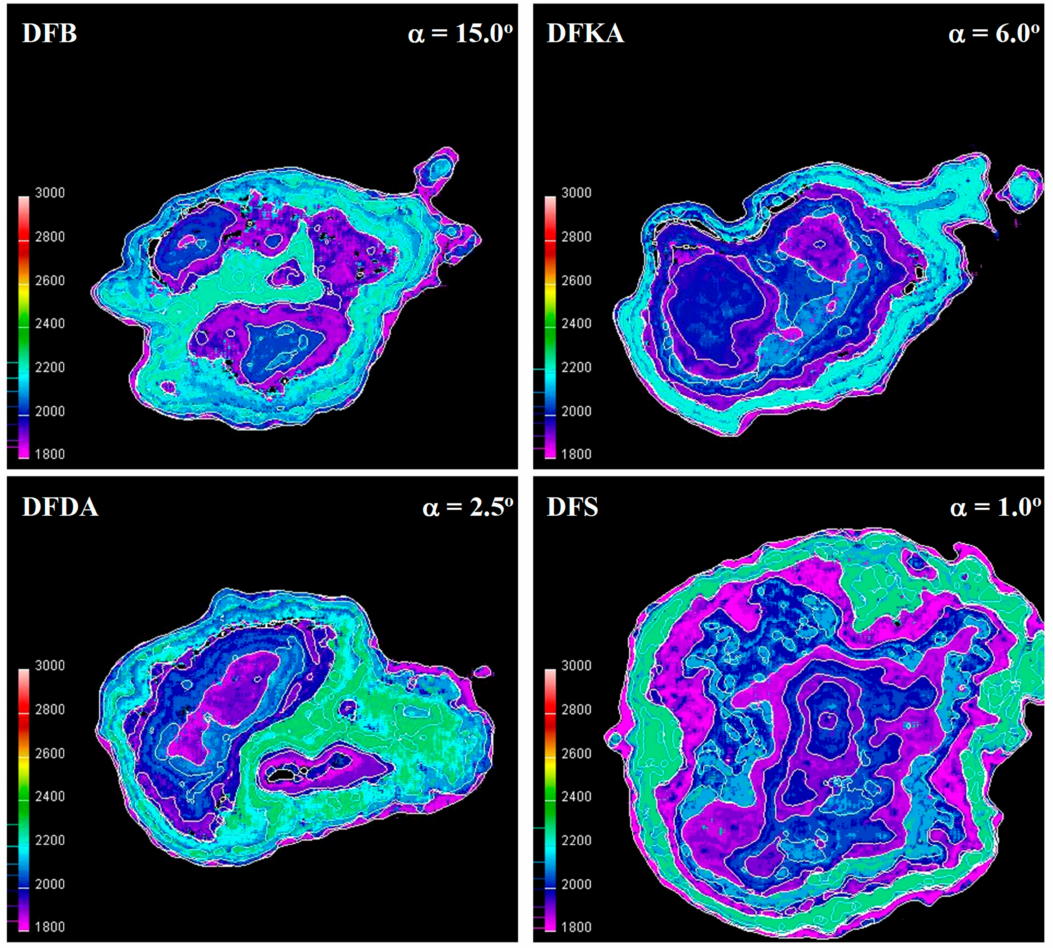
Figure 32. Distribution of isotherms in flame in engine cylinder (over 1800 K) for crankshaft rotation angle corresponding to maximum speed of diffusion combustion α dQd_max .